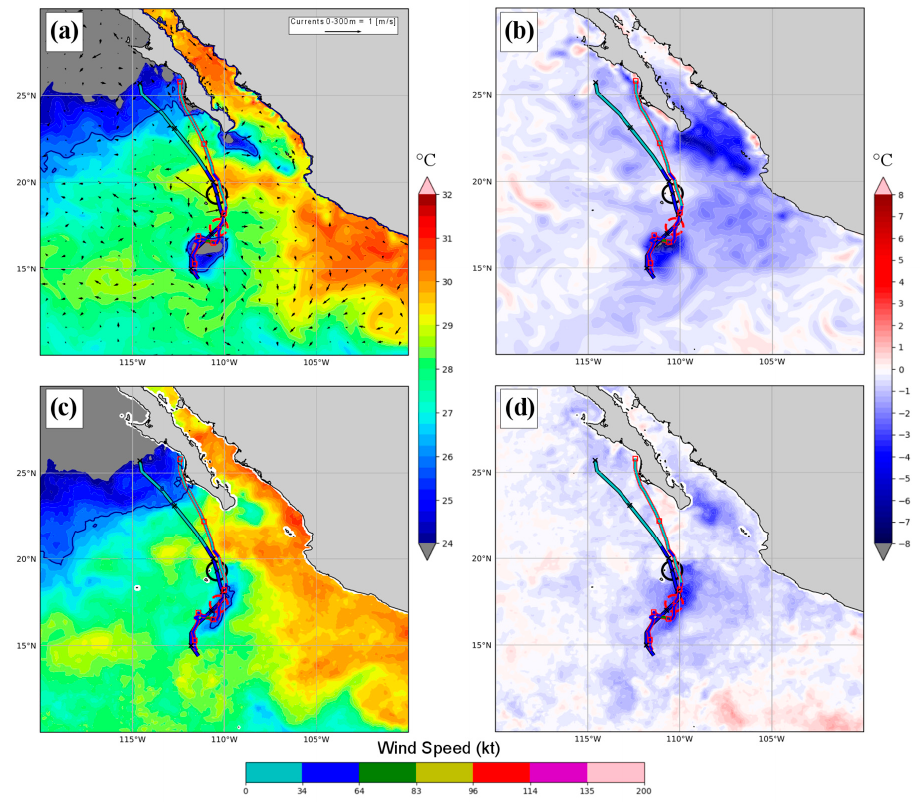
Figure 7. For the case study of Mario (EP142019), sea-surface temperature (SST; a , c ) and SST change ( b , d ) for ( a , b ) MPIPOM-TC model output and ( c , d ) SSTs derived from microwave and infrared satellite radiances (MWIR). The forecast was initialized at 1800 UTC 09 September 2019. SST and SST change are shown for a lead time of 72 h (1800 UTC 12 September 2019); SST changes shown are relative to SST (model or satellite) at the model initialization time. In panel (a), black arrows are drawn to show the direction and speed (scale at center top) of ocean current vectors from MPIPOM-TC, averaged throughout the uppermost 300 m of the water column in each model grid point. The National Hurricane Center (NHC) best track position (black “x” markers) and HWRF-B position (red square markers) at 12 h intervals are superimposed on track forecasts that are color-coded for maximum surface wind speed (bottom color bar). At the forecast time, the azimuthally averaged radius of 34 kt 10 m surface winds is shown for the best track (black solid circle) and HWRF-B (red dashed circle). SST units are in °C and wind speed is in kt.